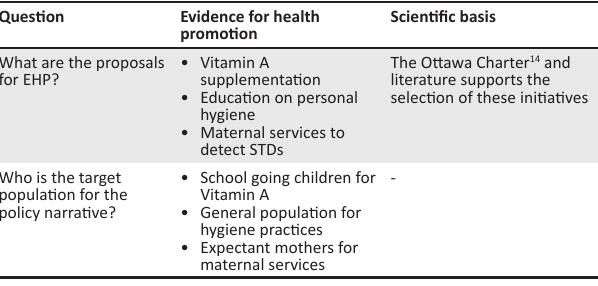
TABLE 2: Analysis of the guideline on management and control of eye conditions at primary level.